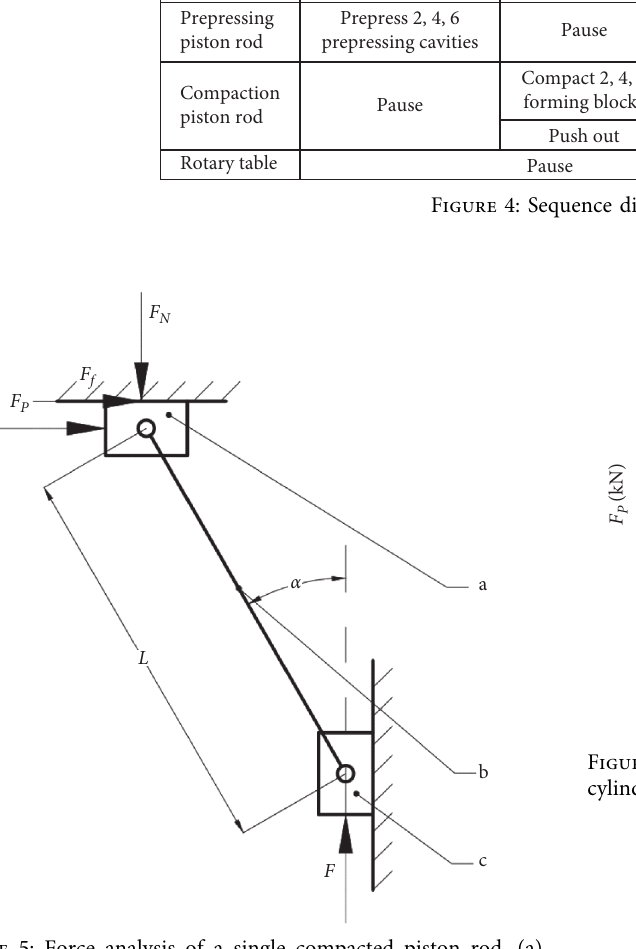
Figure 5: Force analysis of a single compacted piston rod. (a) Compaction piston rod. (b) Connecting rod. (c) Hydraulic cylinder piston rod.